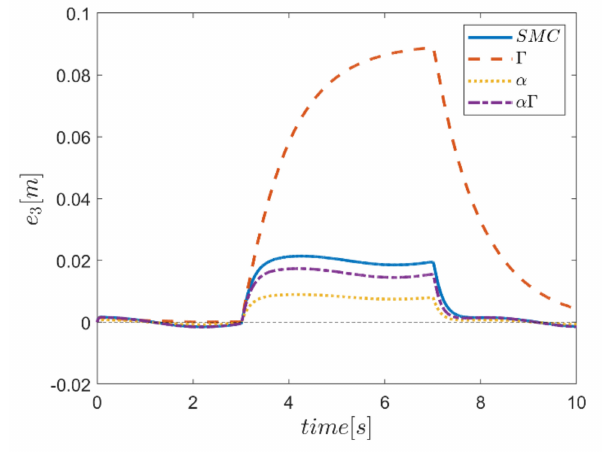
Figure 42. Tracking error in the z channel.